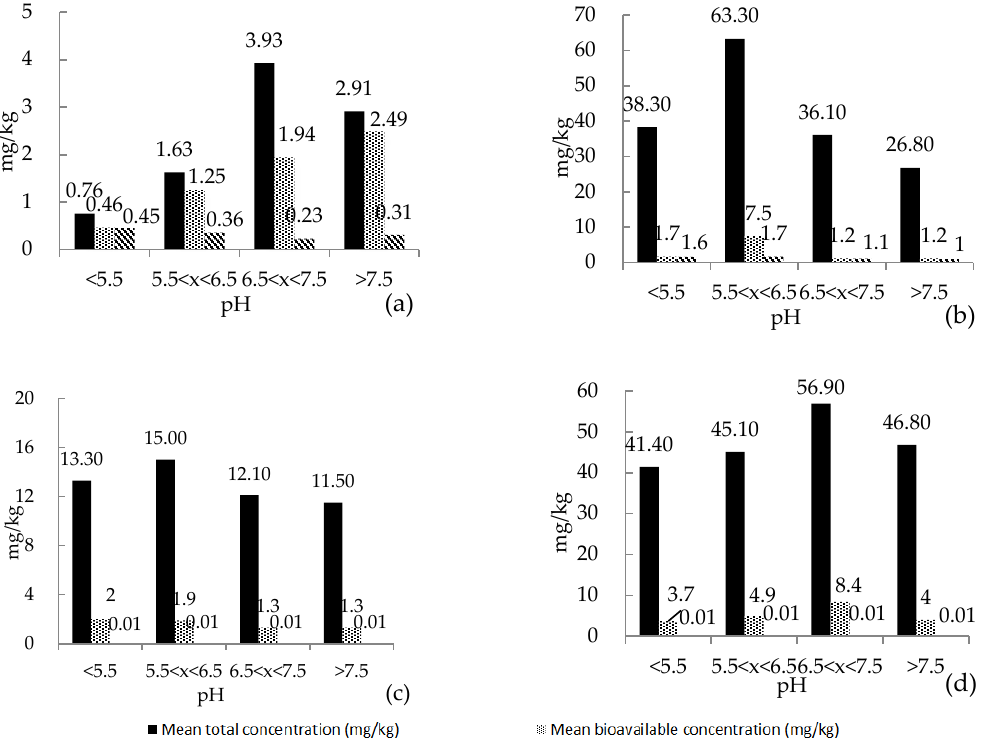
Figure 2. Mean concentration of PTEs in soil (total and bioavailable) and in rice under different pH conditions: ( a ) Cd, ( b ) Cu, ( c ) Co, and ( d ) Pb.